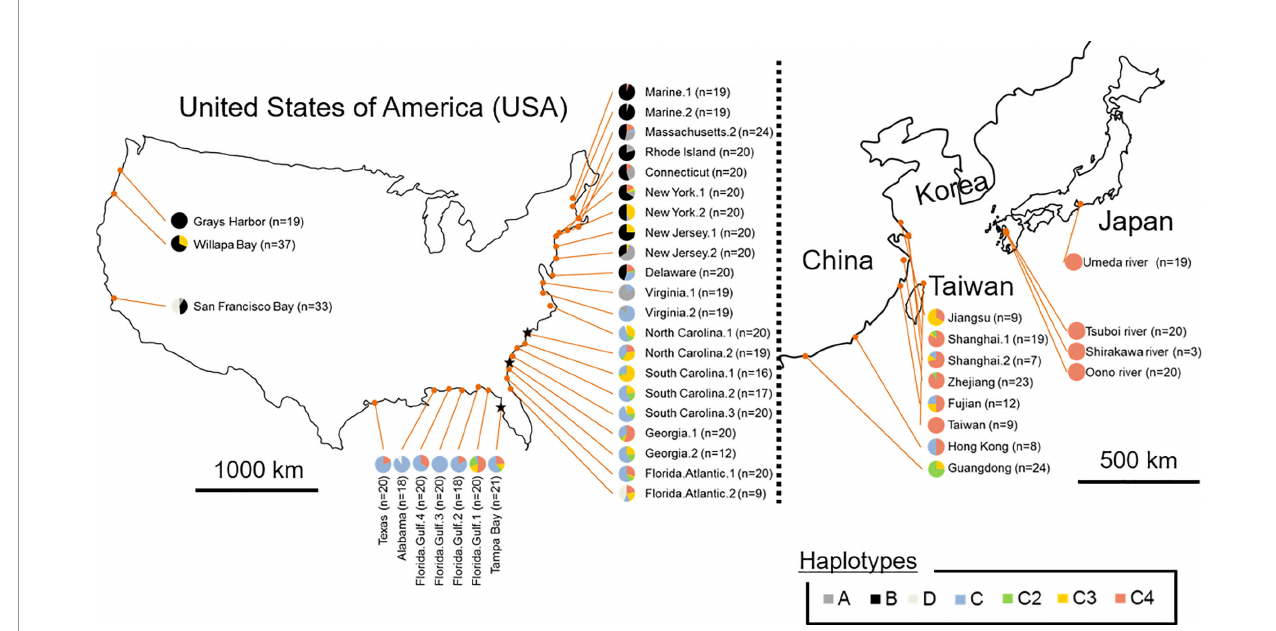
FIGURE 2 | Frequency and distribution of chloroplast DNA (cpDNA) haplotypes in the region of origin (the eastern Unites States) and in the regions where Spartina alterni fl ora had been introduced intentionally and/or unintentionally (the Paci fi c coast of the U.S. and the East Asian countries). Groups A, B, and D consisting of a single haplotype are shown in dark grey, black and light grey, respectively. Haplotype C2, C3, and C4 of Group C consisting of multiple haplotypes are shown in green, yellow, and pink, respectively, and other C members are shown in blue. ★ indicates the region estimated as the place that S. alterni fl ora was initially introduced into China, according to Bernik et al.